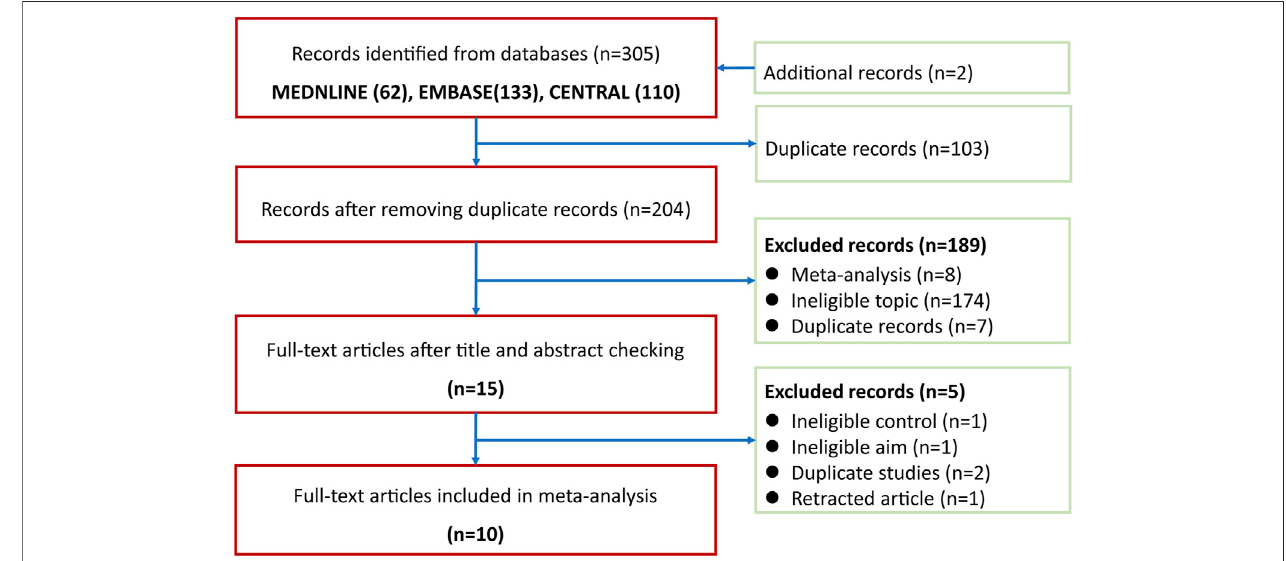
FIGURE 1 | Flow chart of identi fi cation and selection of studies. CENTRAL, the Cochrane Central Register of Controlled Trials.